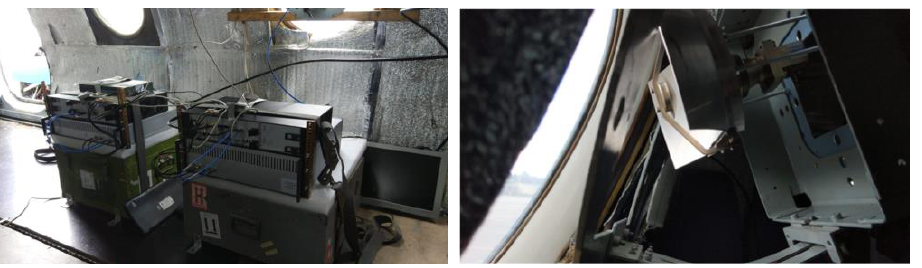
Fig. 7. Transmitters with on-board computers of both bands left) and X-band antenna (right) on the board of flying laboratory.